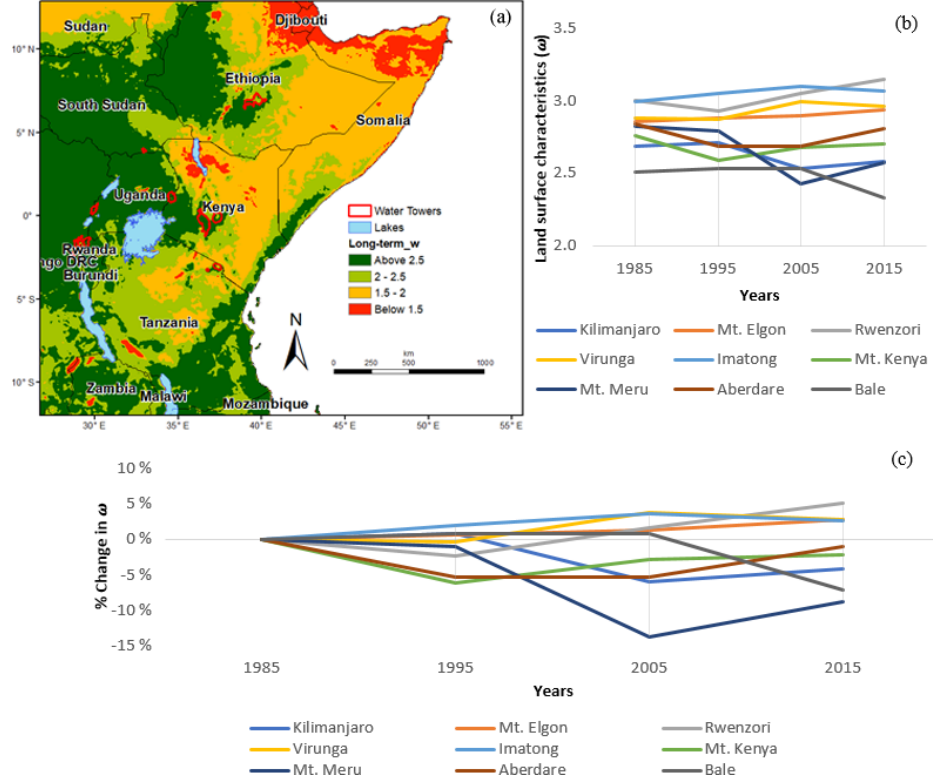
Figure 3. The land surface characteristics. Spatial distribution of the Budyko parameter ( ω ) for 1985 to 2015 (a) and the changes observed between 1985 and 2015 (b) and (c) are